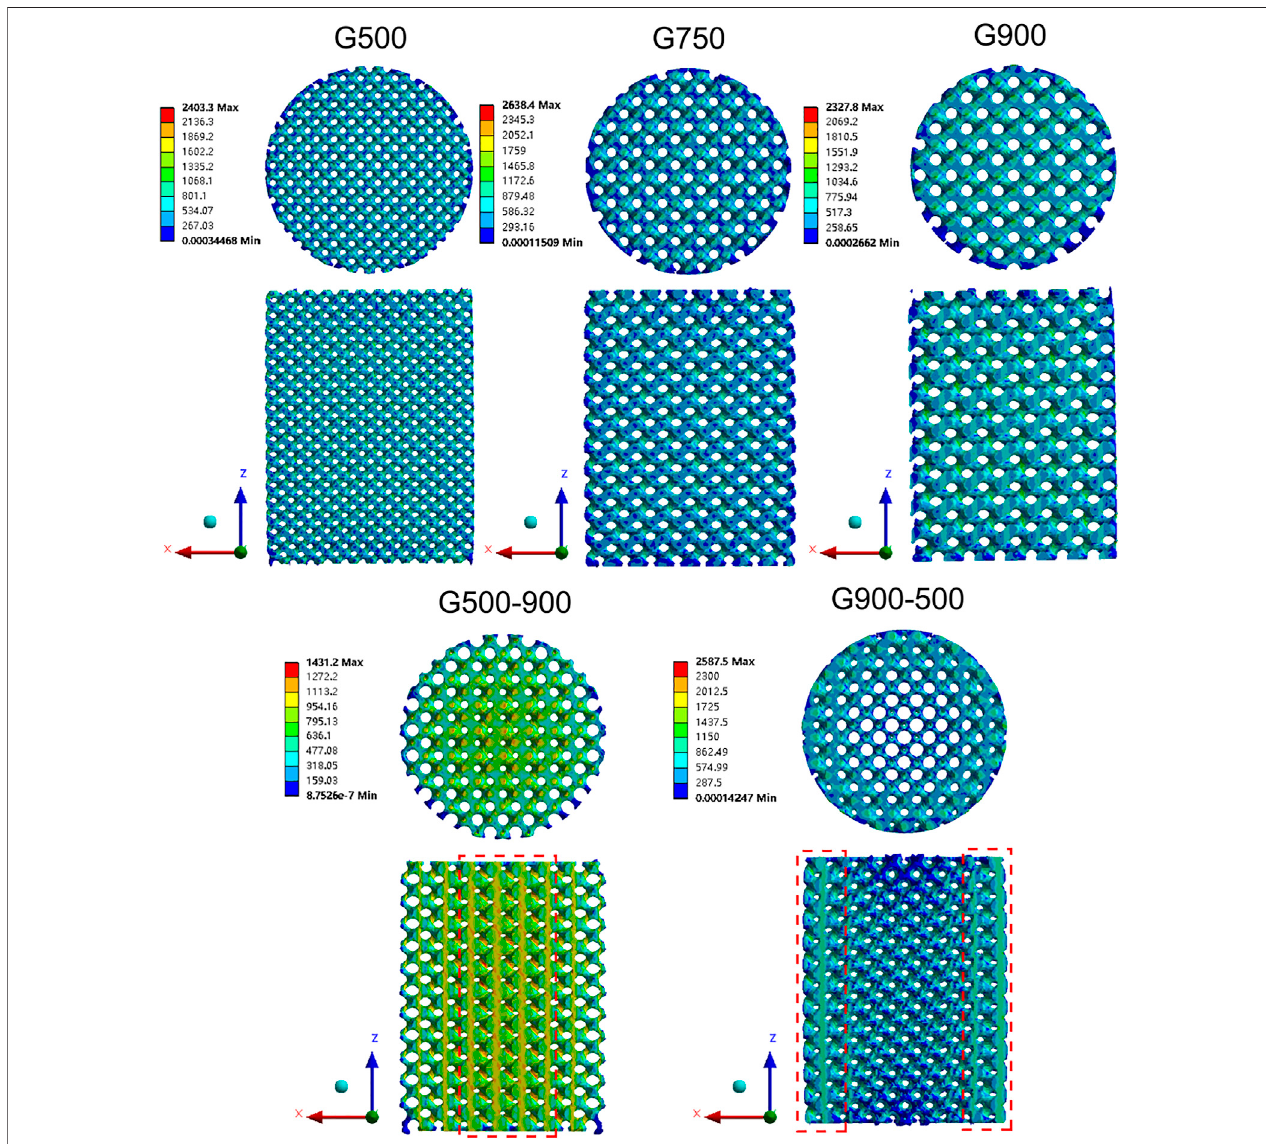
FIGURE 6 | Stress distribution cloud images of the scaffolds under 10% displacement